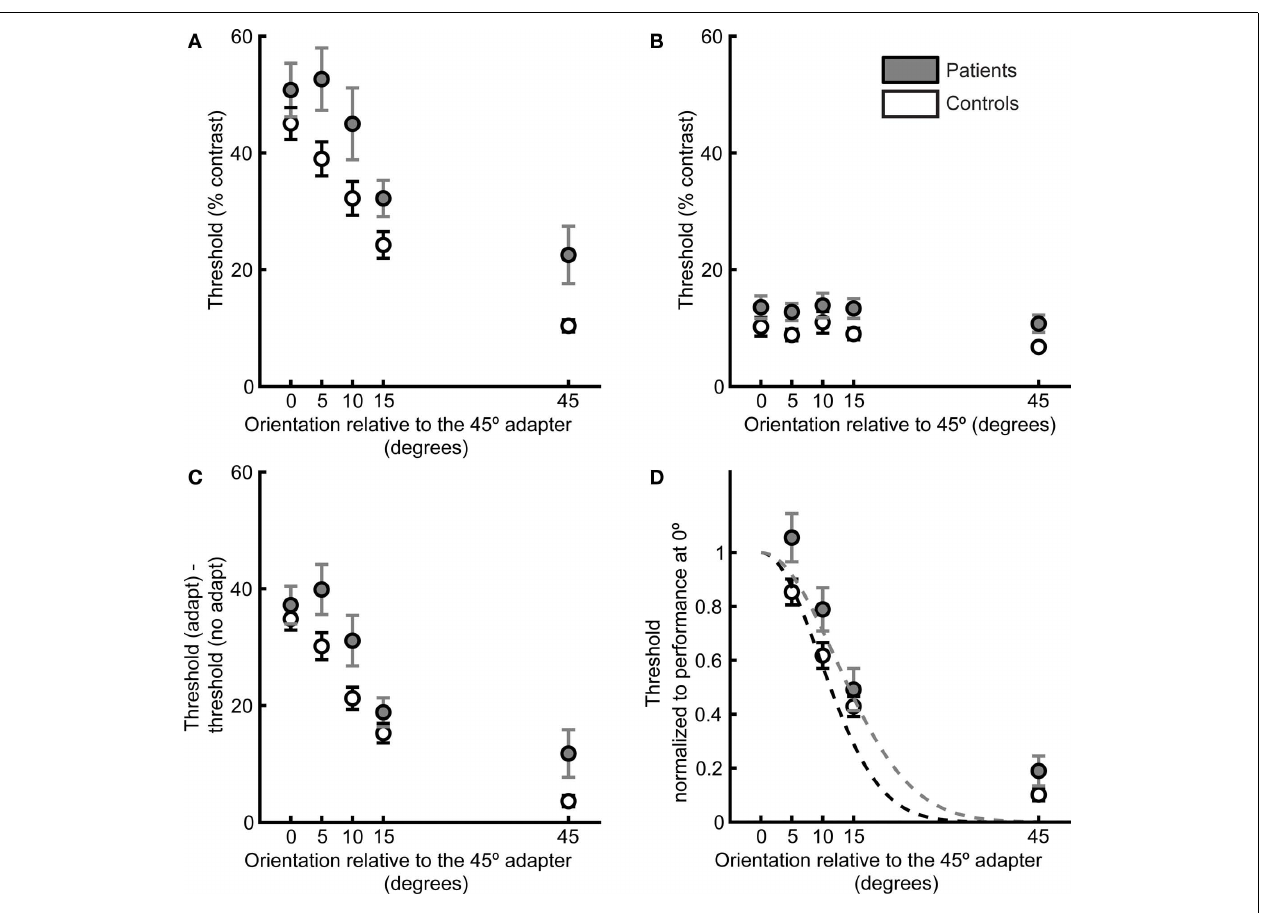
(C) Difference in thresholds in the adaptation and no-adaptation condition. (D) For each participant, thresholds were normalized to performance at 0˚ adapter–target orientation offset, and a Gaussian tuning curve was fit to each participant’s data. Dashed lines indicate the means of the Gaussian fits for each subject group. Error bars indicate SEM for each group and